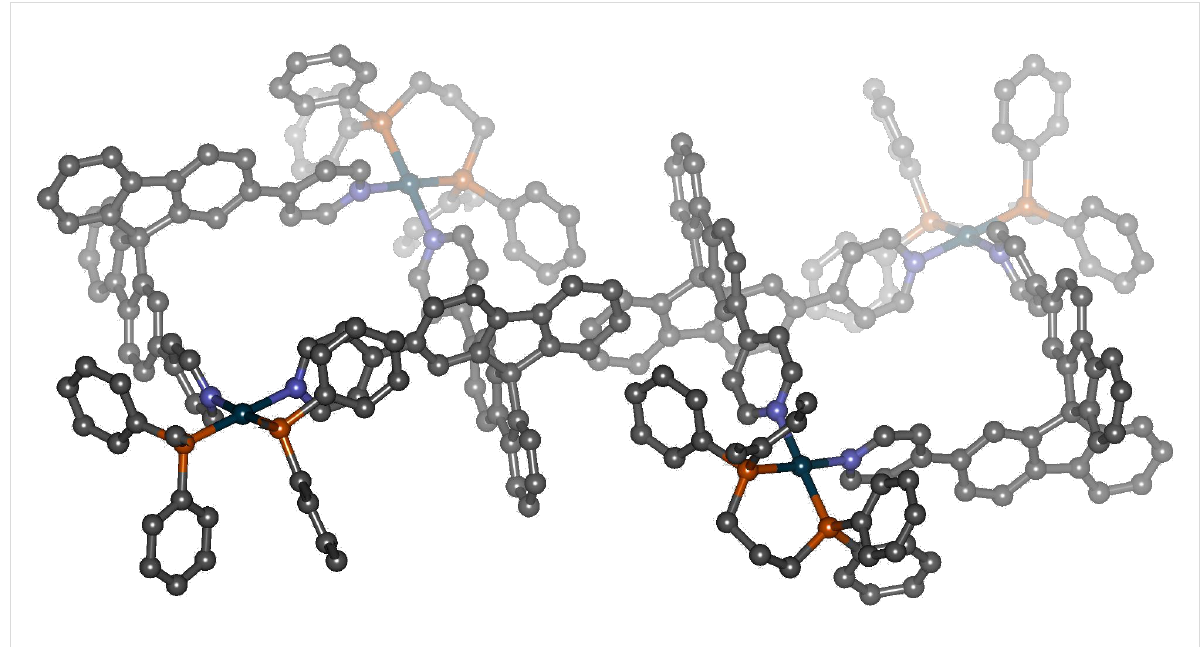
Figure 5: Single crystal X-ray structure analysis of [(dppp) 2 Pd 2 {( R )- 3 } 2 ][(dppp) 2 Pd 2 {( S )- 3 } 2 ](OTf) 8 obtained from a 1:1 mixture of ( rac )- 3 and [(dppp)Pd(OTf) 2 ]. (Counterions and solvent molecules within the crystal packing, and hydrogen atoms are omitted, colour code: petrol – palladium, grey – carbon, blue – nitrogen, orange –